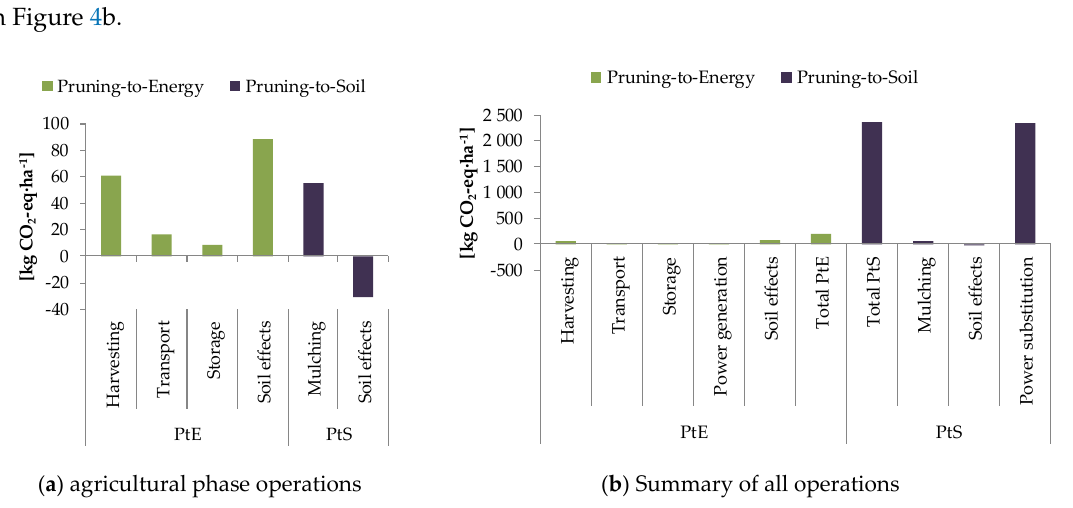
Figure 4. The Climate Change Potential (excl. biogenic carbon) of pruning residues in Spanish peach orchards (pruning residues before harvest: 2.59 tFM · ha − 1 ). ( a ) agricultural phase operations; ( b ) Summary of all